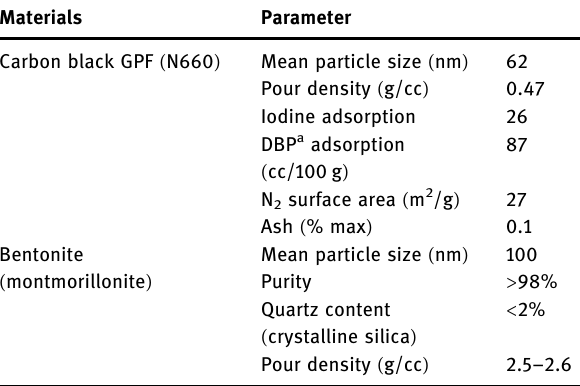
Table 1: Characteristics of bentonite and carbon black